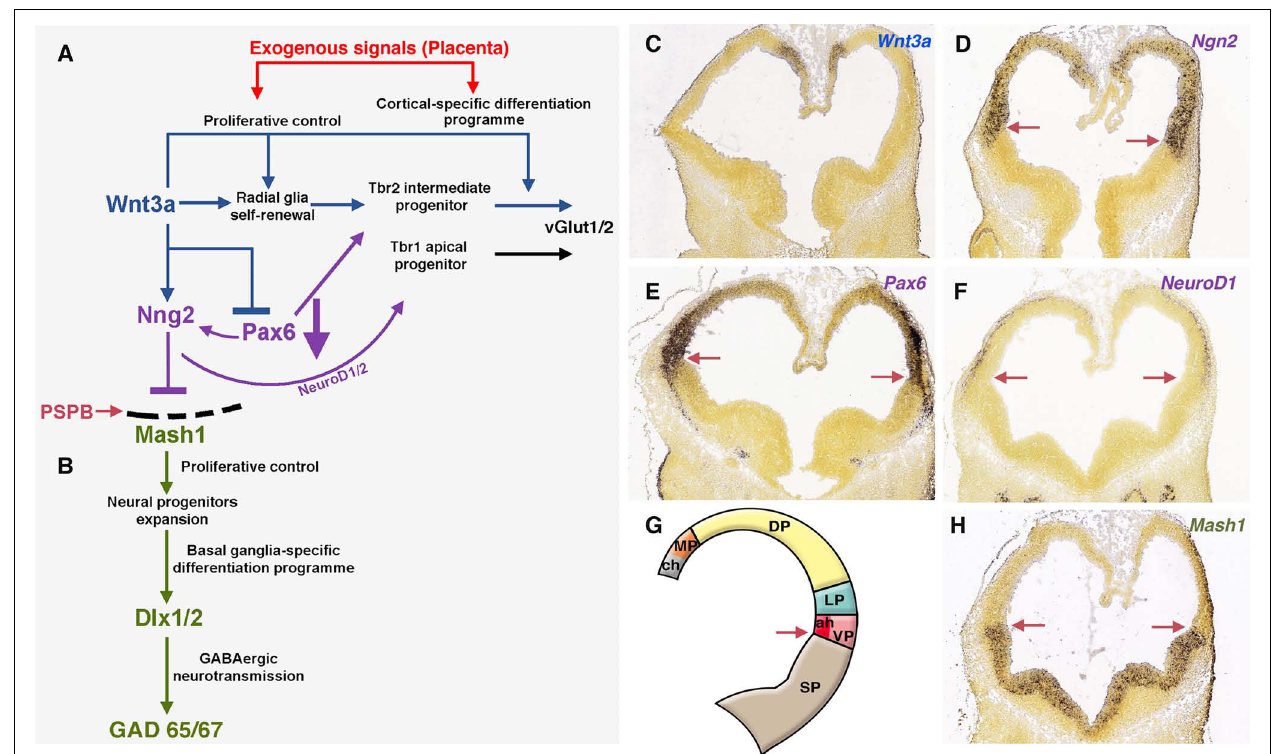
FIGURE 3 | Exogenous signals from placenta would complement telencephalic-signaling control during brain development. (A) The upregulation ofWnt3a trough the canonicalWnt pathway induce self-renewal of radial glia, early differentiation ofTbr2 cortical intermediate progenitors (Munji etal., 2011) and restrict the expansion of the ventral pallium (antihem) driven by Pax6.The antihem express secreted Frizzled-Related Proteins (Sfpr1 and 2, not shown) that neutralize the action of dorsally derived signals like Wnts. Pax6 activates the expression of the dorsal proneural factor neurogenin 1/2 with the consequent activation of NeuroD1/2 and inhibition of Mash1, a proneural factor highly expressed in subpallial domains.Thus, the pallial/subpallial boundary is defined by the limit of expression of Ngn2 and